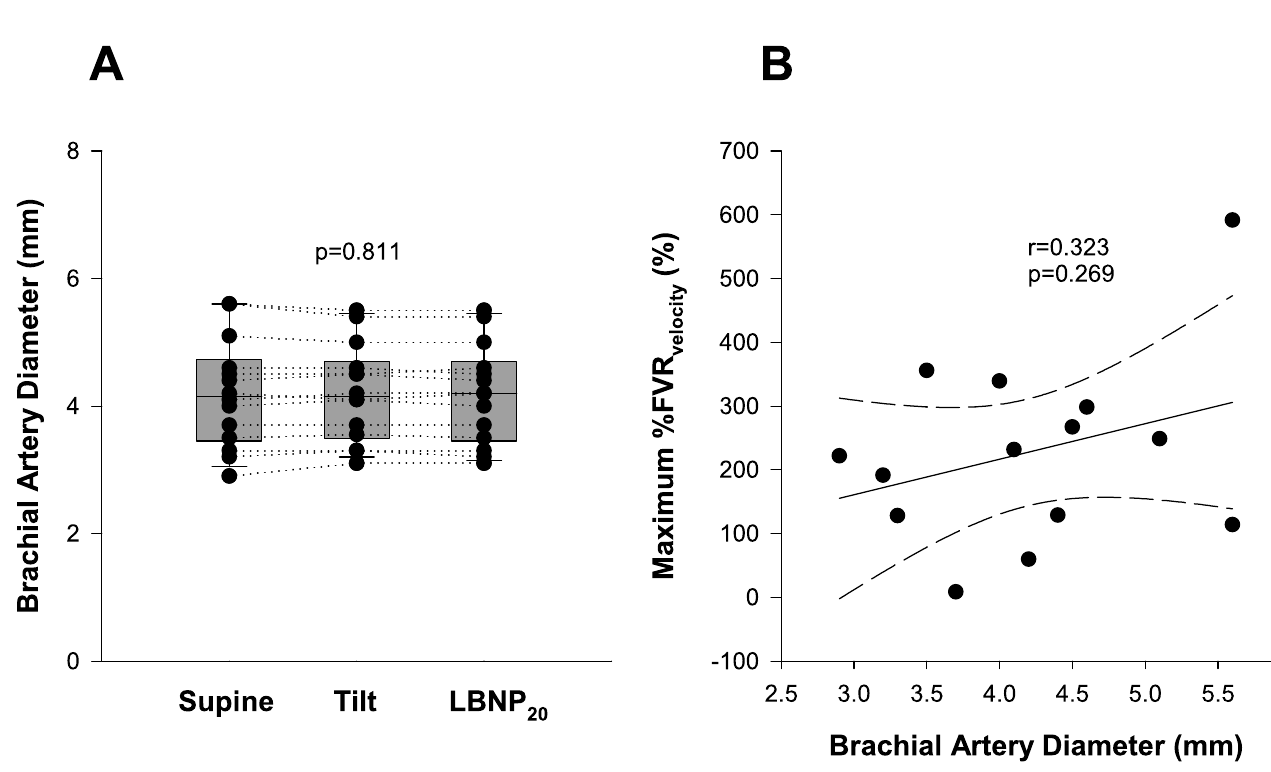
Fig 1. Influence of orthostatic stress on brachial artery diameter and forearm vascular resistance responses (FVR). (A) There were no significant differences in brachial artery diameter between measurements at the end of the supine period (Supine), after 20 minutes of 60˚ head-upright tilt (Tilt) or after a further 10 minutes of head-upright tilt with combined -20mmHg lower body negative pressure (LBNP 20 ). (B) There was no significant relationship between the supine brachial artery diameter and the maximum vascular resistance response to orthostatic stress expressed as the percentage change in FVR velocity relative to supine.